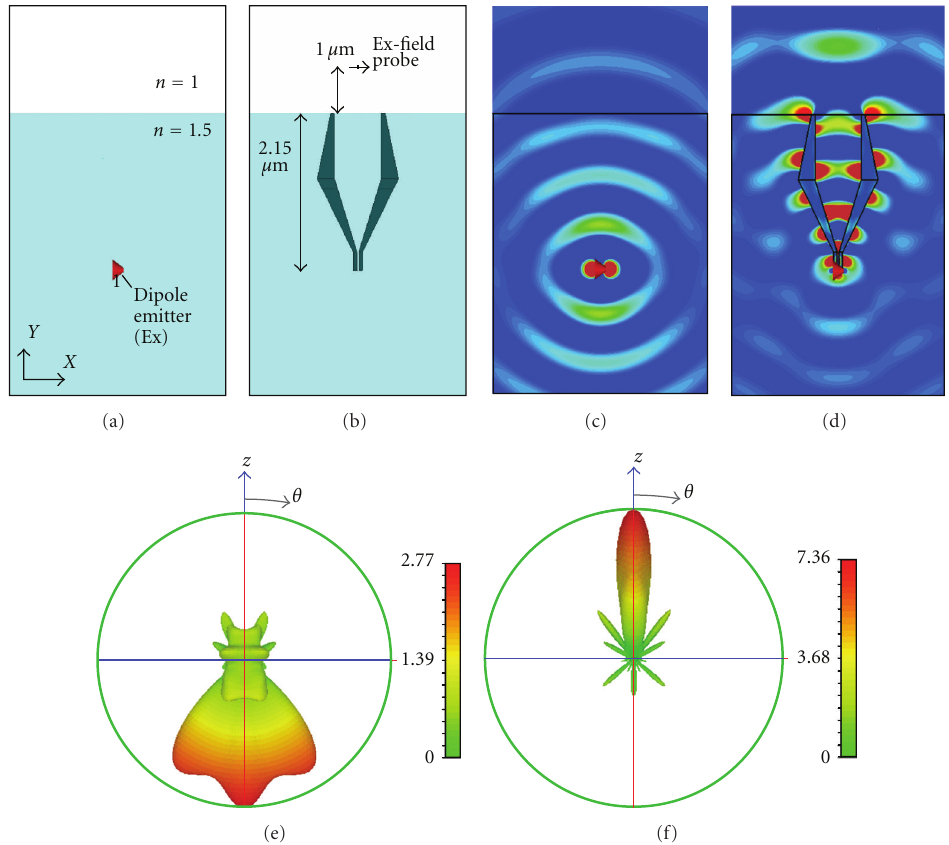
Figure 6: Comparison of far-field radiation of the dipole emitter embedded in high-index material with and without the nanoantenna. (a) Dipole emitted embedded 2.15 µ m below the surface of n = 1 . 5 material, (b) dipole coupled to the nanoantenna, (c) E-field of the dipole emitter, (d) E-field of the coupled dipole-nanoantenna system, (e) far-field radiation pattern of the dipole in high-index material, and (f) far-field of the dipole coupled to the directional nanoantenna. All results are presented at the wavelength 1 µ m.